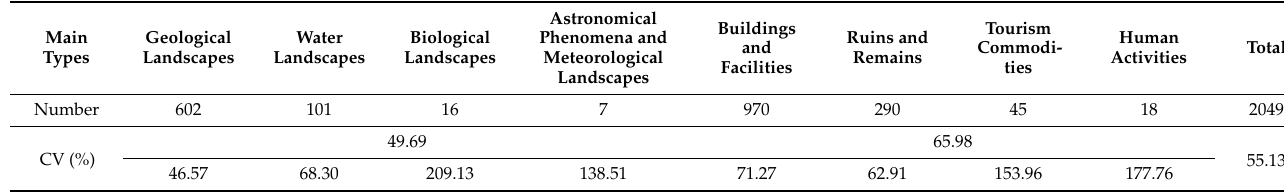
Table 3. Quantity and variation coefficient of tourism resources in Longde